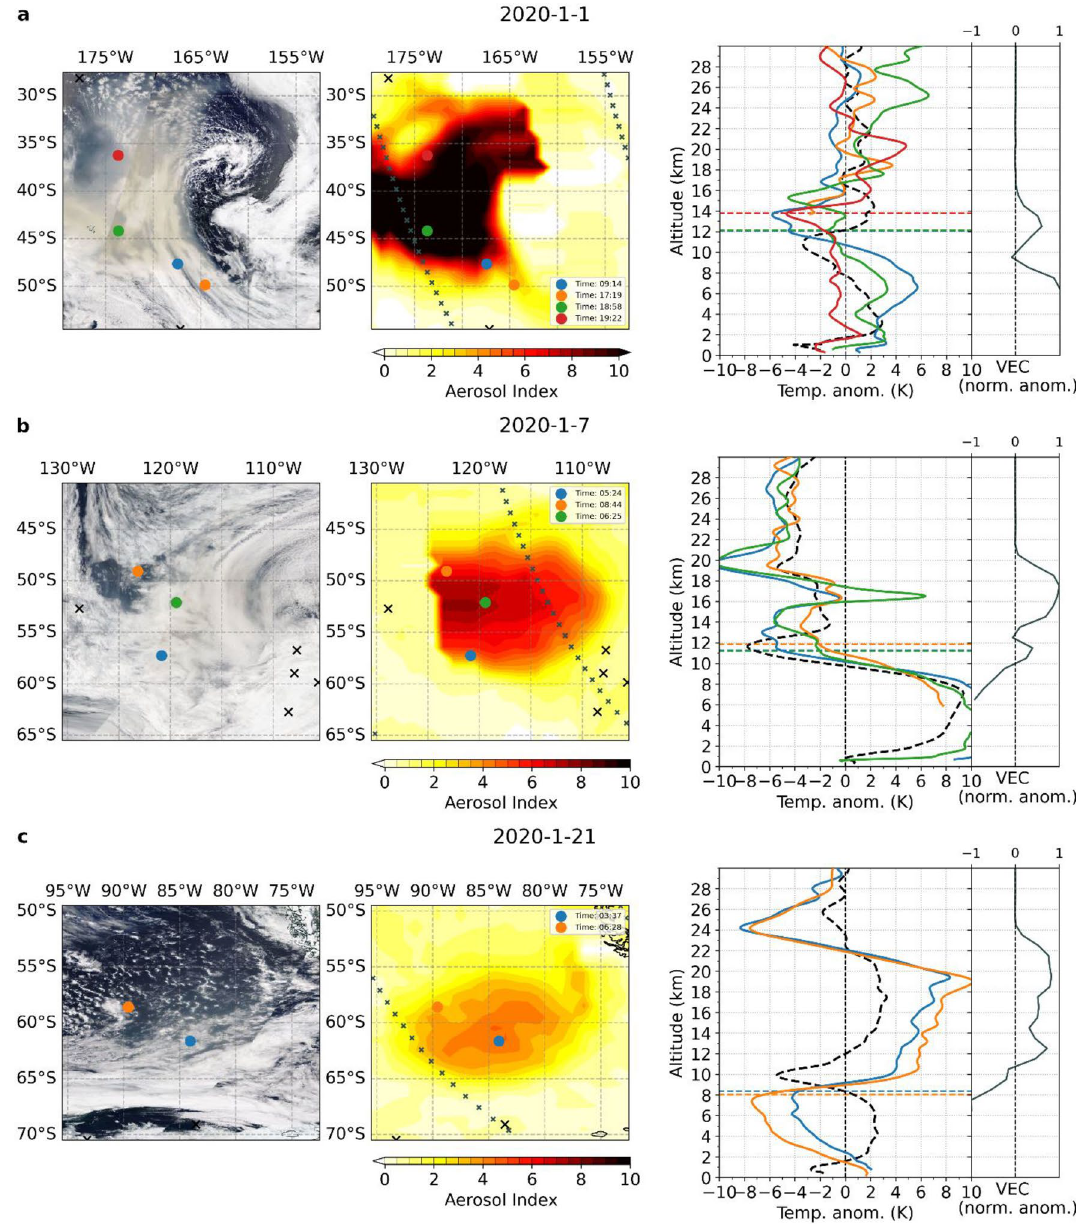
inside the plume (colored lines) as well as the mean temperature anomaly profile outside the plume (dashed line) along with OMPS-LP aerosol anomalies (normalized VEC, relative to the monthly means from 2016 to 2020; right subpanel) for the region investigated on ( a ) January 1, ( b ) January 7, and ( c ) January 21 in 2020. Colored dots/black crosses represent the locations of RO profiles inside/outside the aerosol cloud. Small crosses in the central plot indicate the locations of OMPS-LP measurements. Horizontal colored lines in the right plot indicate the lapse rate tropopause for each respective RO